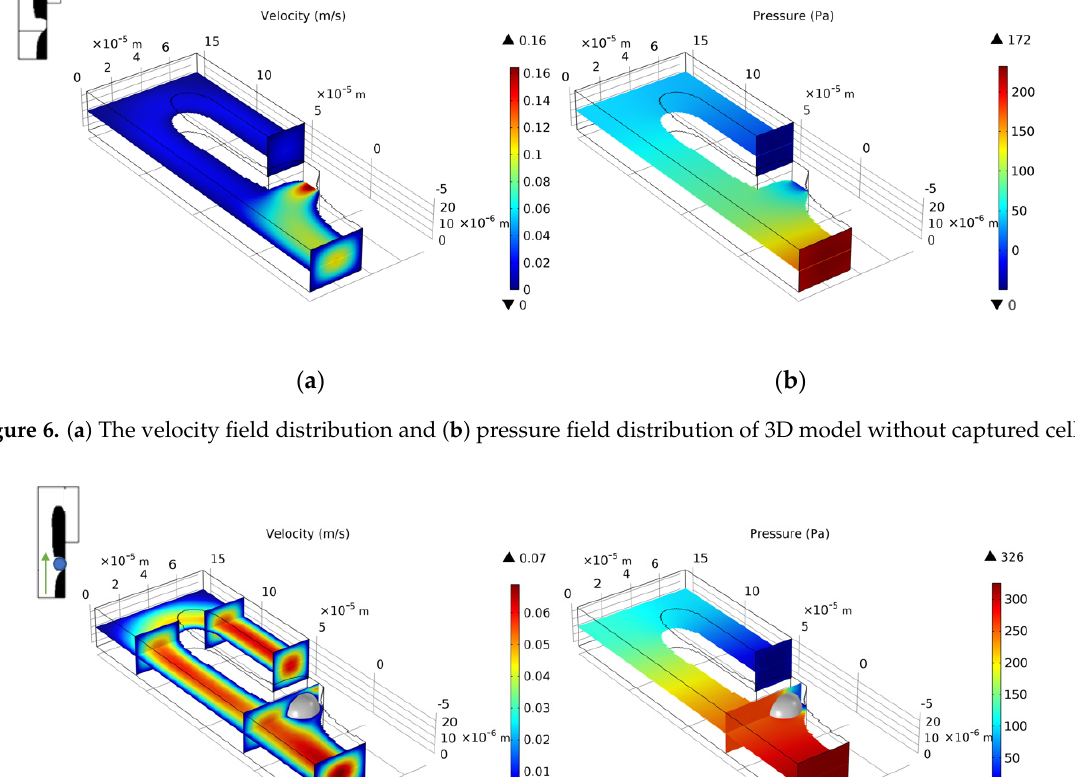
Figure 9. The computational domain 𝛺 = 𝛺 (cid:2887) ∪ 𝛺 (cid:2888) of a three-cell capture unit with the capture chan- nel perpendicular to the inlet channel, where 𝛺 (cid:2888) is the design domain, 𝛺 (cid:2887) is the bypass channel, and 𝛺 (cid:2907) is artificial wall. Figure 10 shows the optimization results of the three-cell capture unit when Re = 1, 𝑛 (cid:2901) = 4:3:2:1, and 𝜃 = 50. As the volume coefficient 𝑏 increases, the fluid material volume fraction of the optimization results increases, and the energy dissipation of the entire fluid calculation area decreases as the volume fraction increases. It can be observed that the value of energy dissipation is divided into two stages: when the volume coefficient 𝑏 < 5, as the volume coefficient 𝑏 increases, the width of the three trapping channels gradu- ally increases, and the overall energy dissipation value of the trapping unit decreases sig- nificantly; when the volume coefficient 𝑏 > 5, there is no solid material between the inlet and the first trapping channel to be optimized. At the same time, to ensure the flow rate ratio among the outlets of each channel, further increasing the volume coefficient 𝑏 will not cause a large change in the volume fraction in the design domain, and the overall energy dissipation value of the capture unit is basically unchanged.